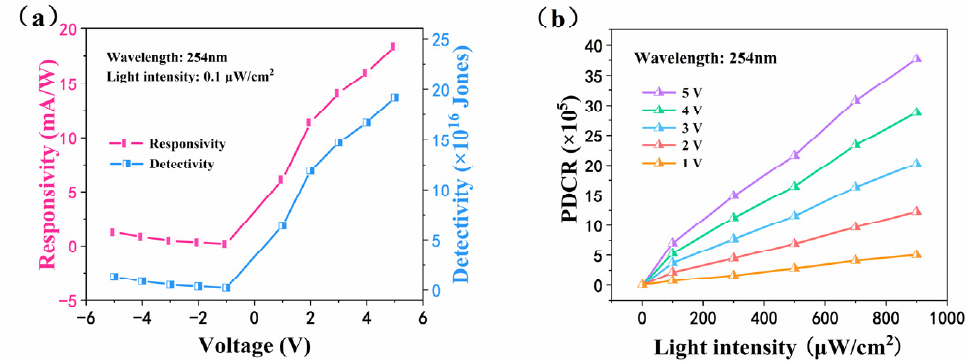
Figure 5. ( a ) The responsivity ( R ) and the detectivity ( D* ) of the heterojunction device with an intensity of 0.1 mW/cm 2 under different voltages from − 5 V to 5 V, voltage step is 1 V. ( b ) The PDCR versus different light intensities under 1 V, 2 V, 3 V, 4 V, and 5 V, respectively. For an integrated understanding of the operating mechanism of the CoPc/Ga 2 O 3 heterojunction device, the energy band alignment before contact and after contact are shown in Figure 6a,b, under dark and 254 nm light are shown in Figure 6c,d, and under forward and reverse voltage are shown in Figure 6e,f. Combining the bandgap calculation results in this work with previous reports, the conduction band ( Ec ) and valence band ( Ev ) of Ga 2 O 3 were determined to be 4.0 eV and 8.85 eV, the lowest unoccupied molecular orbital ( LUMO ) and highest occupied molecular orbital ( HOMO ) of CoPc were determined to be 3.4 eV and 4.95 eV [16,30]. The work functions of Ga 2 O 3 and CoPc are 4.06 eV and 4.4 eV, respectively [30,31]. The band bending is caused by the difference in the Fermi energy levels of Ga 2 O 3 and CoPc. According to Anderson’s law, the offsets of the conduction band and valence band ( ∆ Ec and ∆ Ev ) were determined to be 0.6 eV and 3.9 eV, respectively [32]. The noise of the heterojunction comes mainly from the dark current. The lower dark current of the device is due to rare intrinsic carriers without illumination. After the contact between Ga 2 O 3 and CoPc, electrons flow from Ga 2 O 3 to CoPc, and holes flow from CoPc to Ga 2 O 3 . In order to maintain the equilibrium of the Fermi energy levels of the heterostructure, the energy band of Ga 2 O 3 would move lower and bend upward at the interface, and the energy band of CoPc would move higher and bend downward at the interface. With the diffusion movement of carriers, the built-in electric field is formed at the heterojunction interface, and the formation of the space charge region leads to the depletion layer [33]. When the device exposed to ultraviolet light, the electron-hole pairs are excited in Ga 2 O 3 , which are separated under the effect of the built-in electric field and flow to the corresponding electrodes, resulting in a circuit inside the heterojunction, so the device can operate under self-powered mode. When a forward voltage is applied to the device, the direction of the external voltage is opposite to the built-in electric field, the width of the depletion layer decreases, and carriers can easily transfer through the barriers, resulting in a high current. When the reverse voltage is applied to the device, the direction of the external voltage is the same as the built-in electric field, the width of the depletion layer increases, and the carrier transport is suppressed, resulting in a limited current [34]. The experimental results show that the device has a superior rectification characteristic, which is consistent with the analysis of the energy band